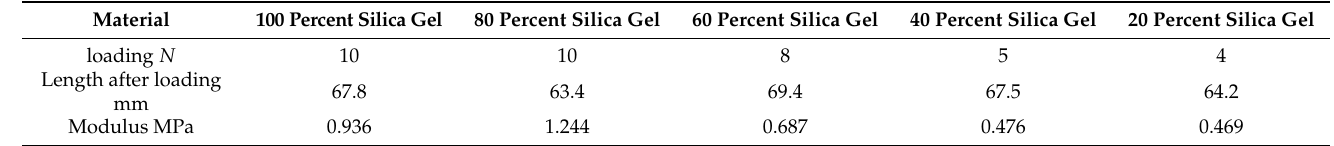
Table 1. Elastic modulus of samples with different proportions of glass